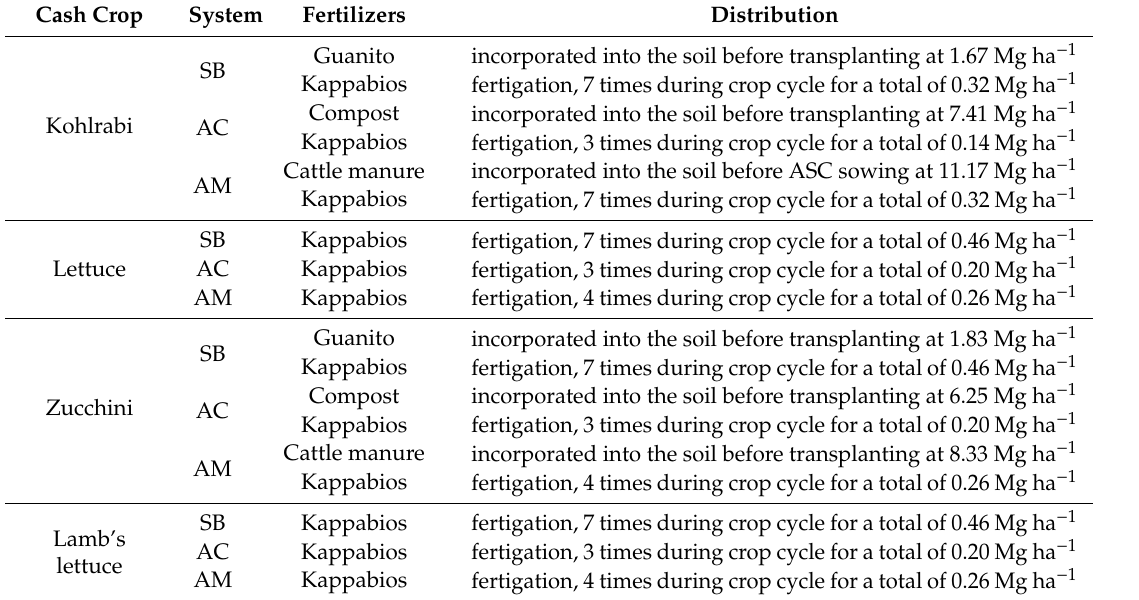
Table 3. Distribution of amendments and fertilizers to the three systems for each crop (on dry matter basis, except for “Kappabios”, in liquid